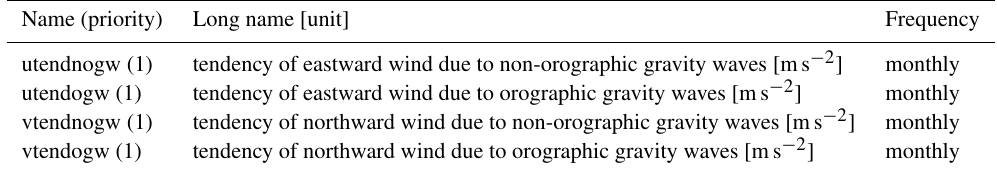
Table 3. Momentum (atmosphere). Monthly mean variables (3-D, grid: XYZT) on the plev19